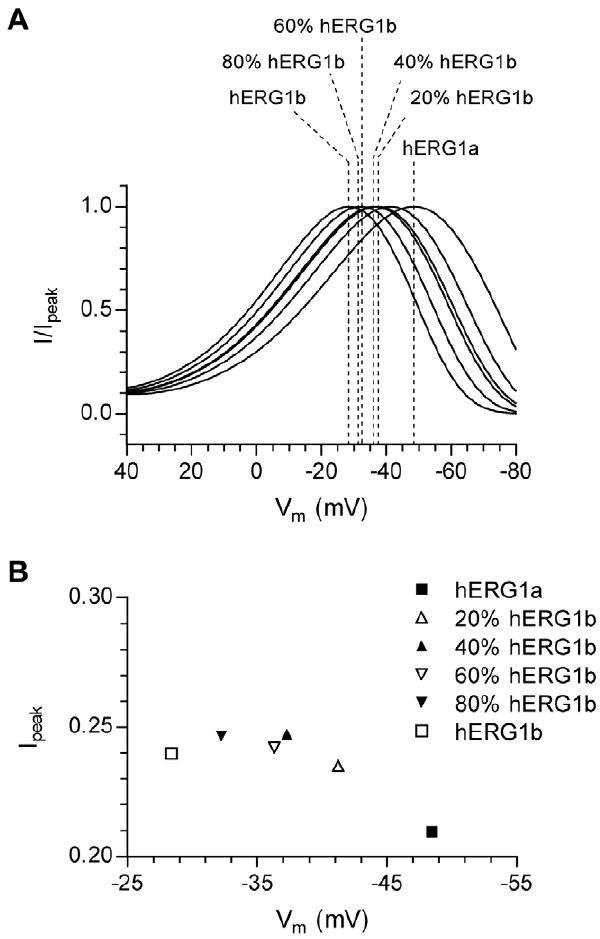
Figure 4. The experimental data is reproduced by a hERG1 Markov model. A, The effect of changes in transition rates, representing a gradual increase in the relative abundance of hERG1b, on simulated hERG1 currents. The transition rates of hERG1 channel activation ( a 3 ), deactivation ( b 3 ) and recovery from inactivation ( b 4 ) were modified to represent a gradual increase in the relative abundance of hERG1b (see table S2 for details). The model was subjected to the same voltage protocol as in figure 2A. Only currents recorded during the ramp are shown. For comparison, currents were normalized to the maximum peak current during the ramp and plotted against the command voltage. The dotted lines indicate the potential where the currents peaked (‘peak potential’) and are also used to indicate the isoform ratio (in % of hERG1b abundance). B, The variation in ‘peak potential’ amplitude is shown as a function of ‘peak potential’. The data were not normalized as the number of channels in the model remained